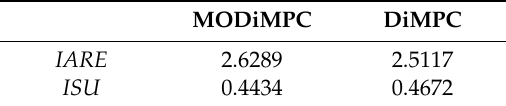
Table 6. Performance indexes for IARE and